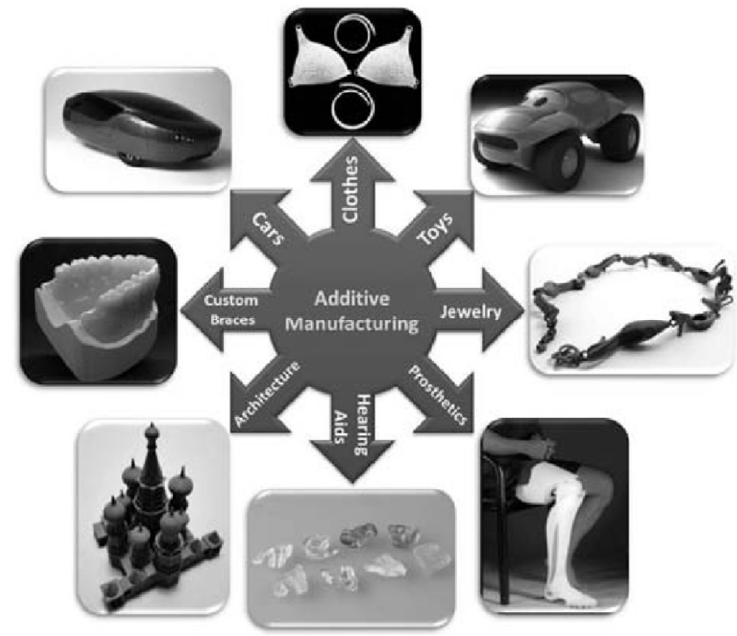
Figure 8. The use of AM in different industry sectors [51].